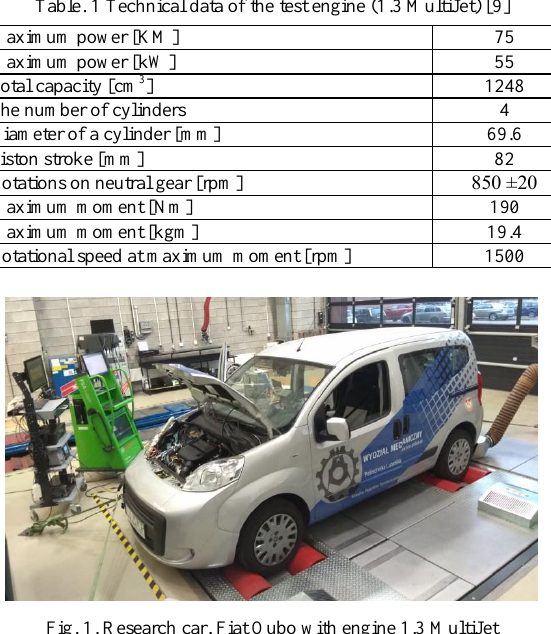
Fig. 1. Research car, Fiat Qubo with engine 1.3